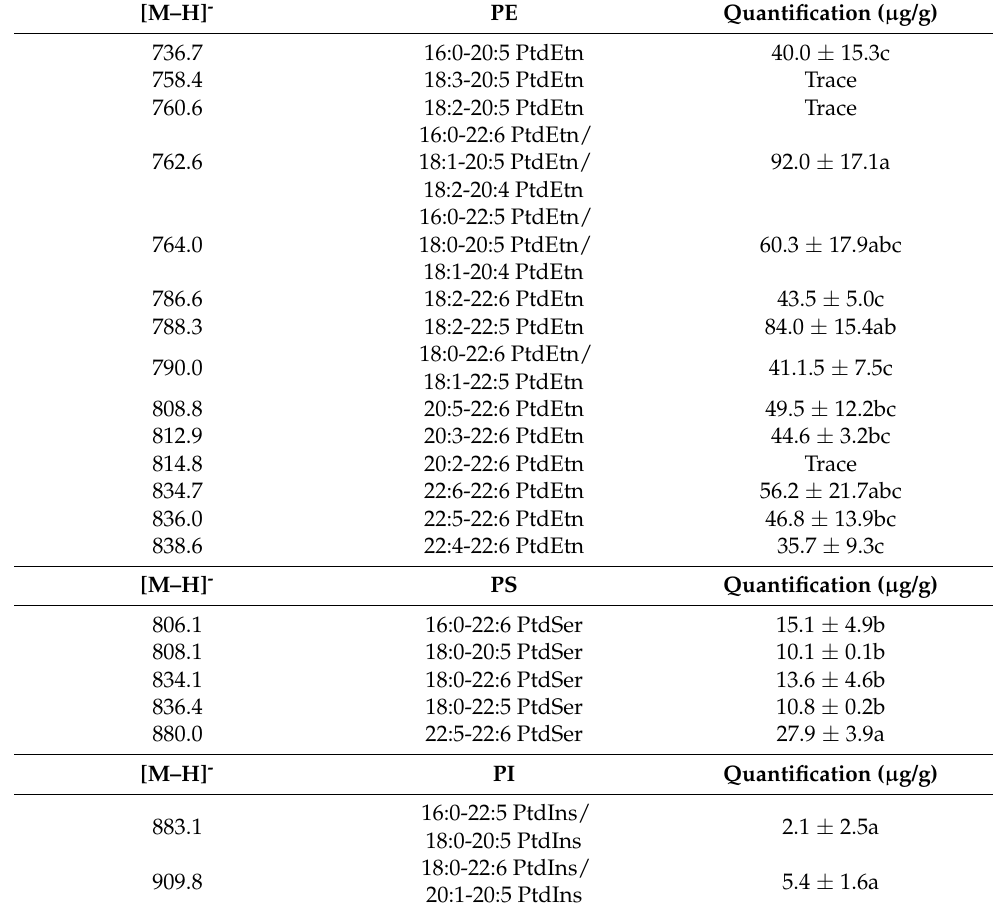
Table 1. Quantification of phosphatidylethanolamines (PEs), phosphatidylserines (PSs), and phos- phatidylinositols (PIs) in salmon muscle tissue.